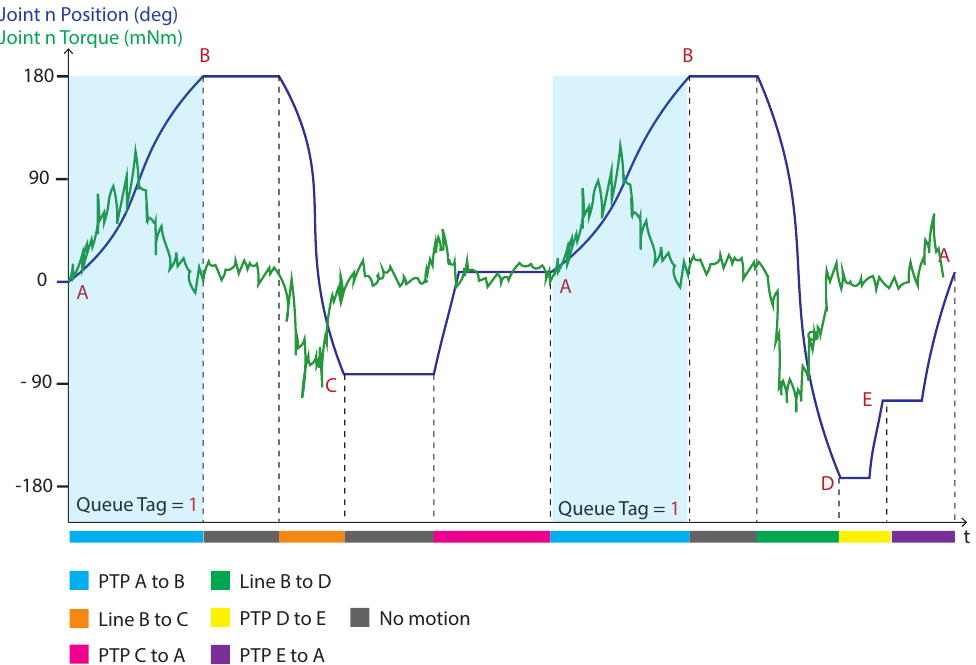
Figure 3. Example of a single joint n position and torque acquisition during the execution of the “Test” program. The colors below the graph’s x axis represent the motion commands executed during the